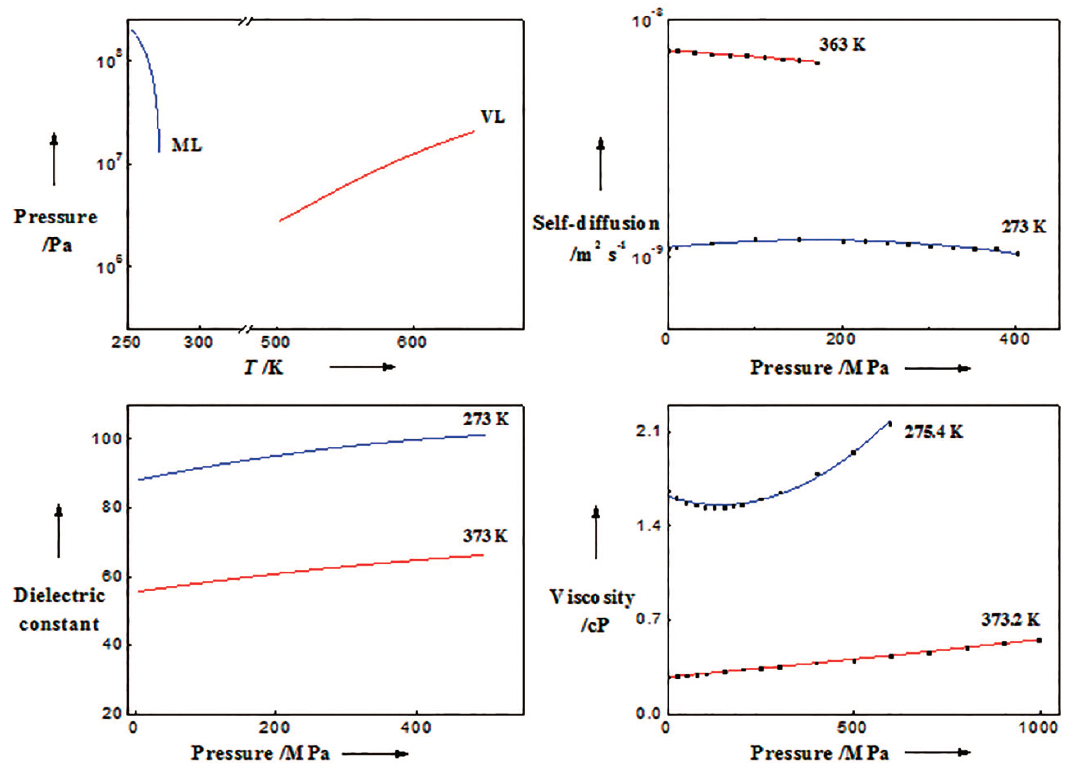
Figure 5. Pressure-dependent variations in four macroscopic parameters within different temperature ranges or at typical temperature points. There are two lines in each panel characterized by blue and red color representing for the low and high temperature lines, respectively. The left panel in the top line shows the melting line and vaporization line adapted from Dunaeva et al. [101], and Chaplin [102], respectively. The pressure dependence of self-diffusion, dielectric and viscosity are shown in other three panels which are adjusted from Prielmeier et al. [98], Uematsu and Frank [99], and Bett and Cappi [96],